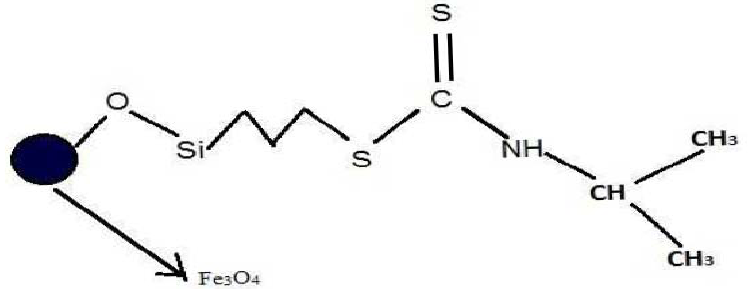
Fig. 2. The chemical structure of the synthesized novel